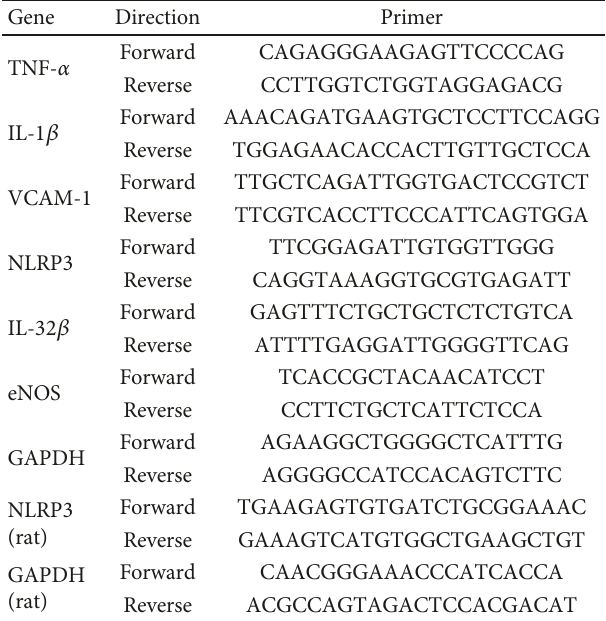
Table 1: Quantitative RT-PCR primer